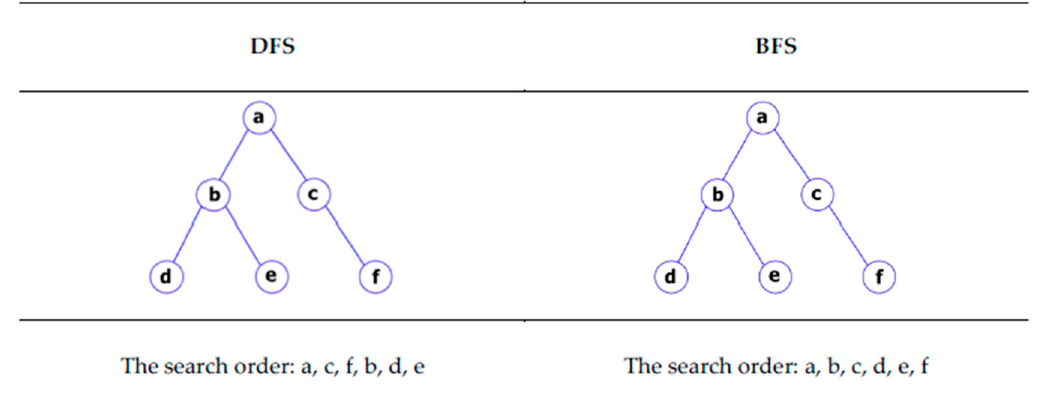
Figure 3. Diagram of depth-first search (DFS) and breadth-first search (BFS).